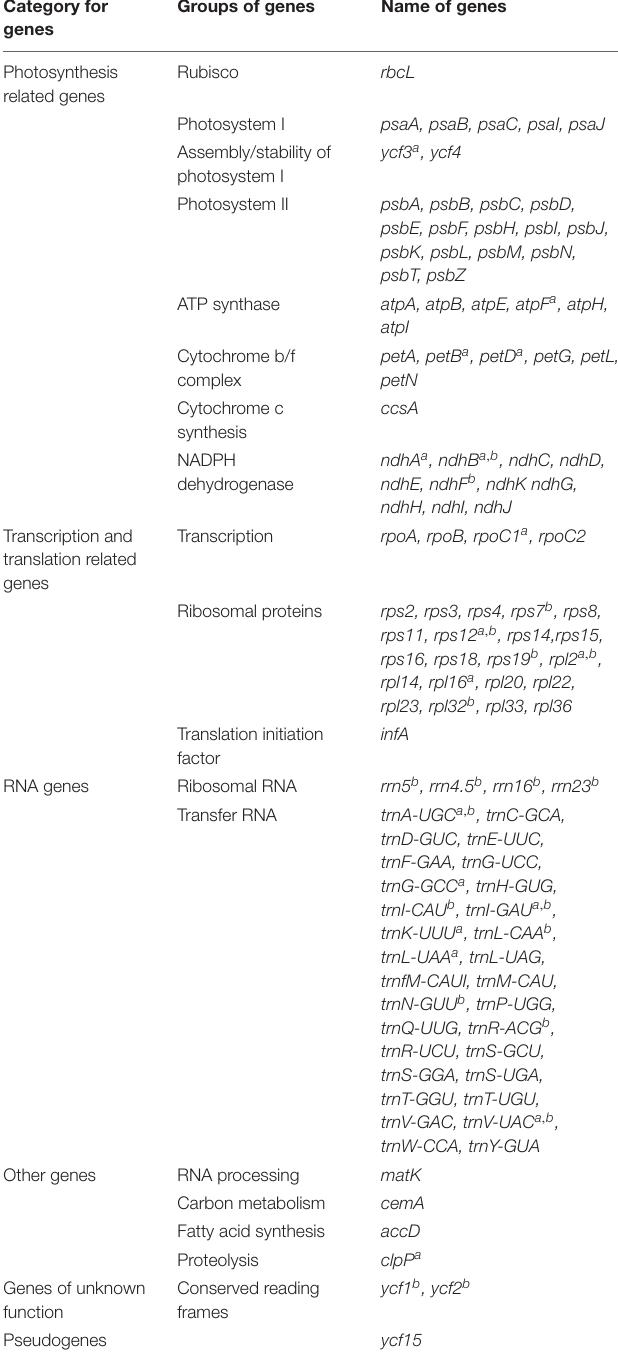
TABLE 2 | Genes contained in the chloroplast genome of eight Fagopyrum